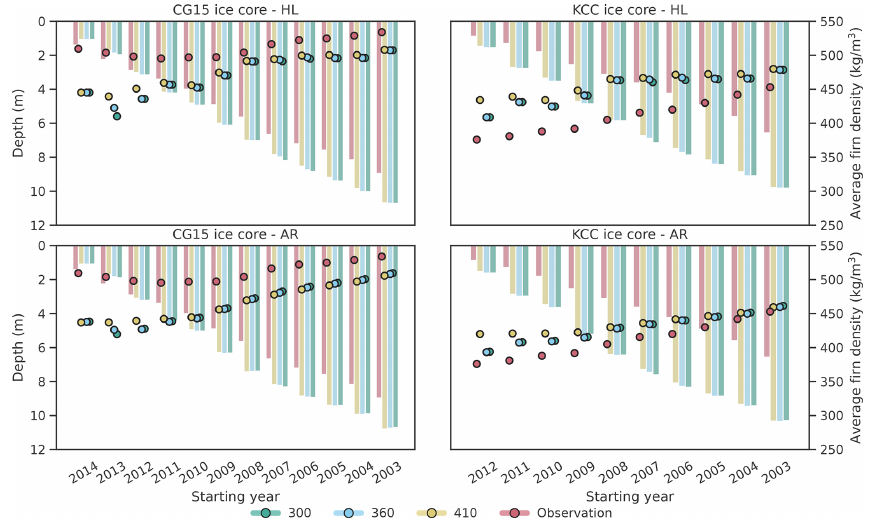
Figure 7. Observed and modelled (with one-layer version) average firn density (dots, right axis) and depth (bars, left axis) for KCC and CG15. Each cluster corresponds to a run of the model whose starting date is reported on the x axis. The ending year for all runs is 30 August 2013 for KCC and 30 September 2015 for CG15. AR and HL stand for the model versions with Arnaud et al. (2000) and Herron and Langway (1980) implemented, respectively. The values 300, 360 and 410 stand for the chosen value of ρ D .